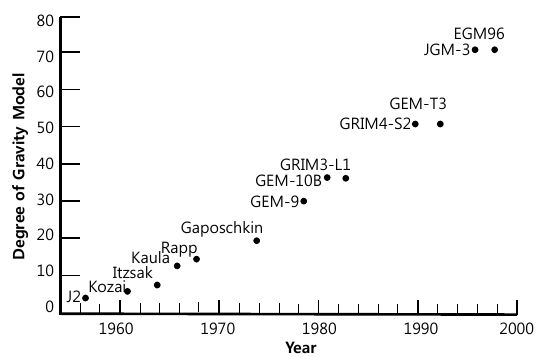
Figure 8. Evolution of complexity in Earth gravity models [13].